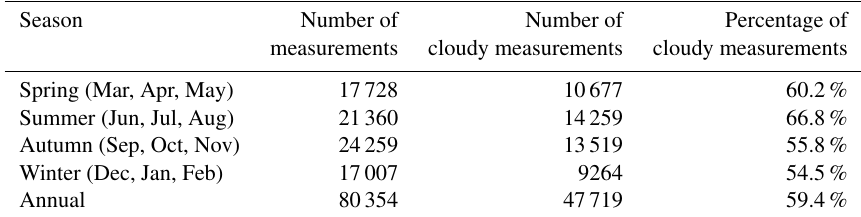
Table 2. Summary of cloud screening results. Season Number of Percentage of measurements cloudy measurements cloudy